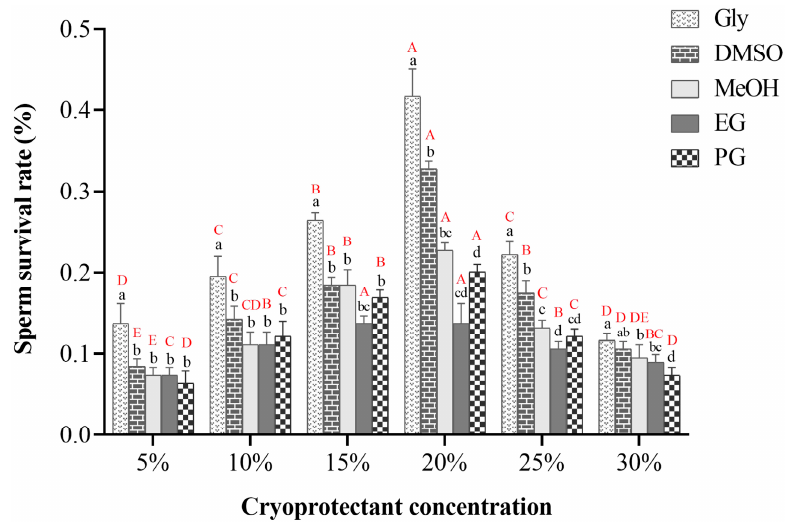
Figure 2. Survival rates of sperm of P. trituberculatus after the application of different kinds and concentrations of cryoprotectants. Different lower-case letters indicate the significant difference in the freezing effect of different cryoprotectants at the same concentration ( p < 0.05). Different capital letters indicate differences in the freezing effect of different concentrations of the same cryoprotectant ( p < 0.05). Gly: glycerol, DMSO: dimethyl sulfoxide, MeOH: methanol, EG: ethylene glycol, PG: propylene glycol ( n = 60).